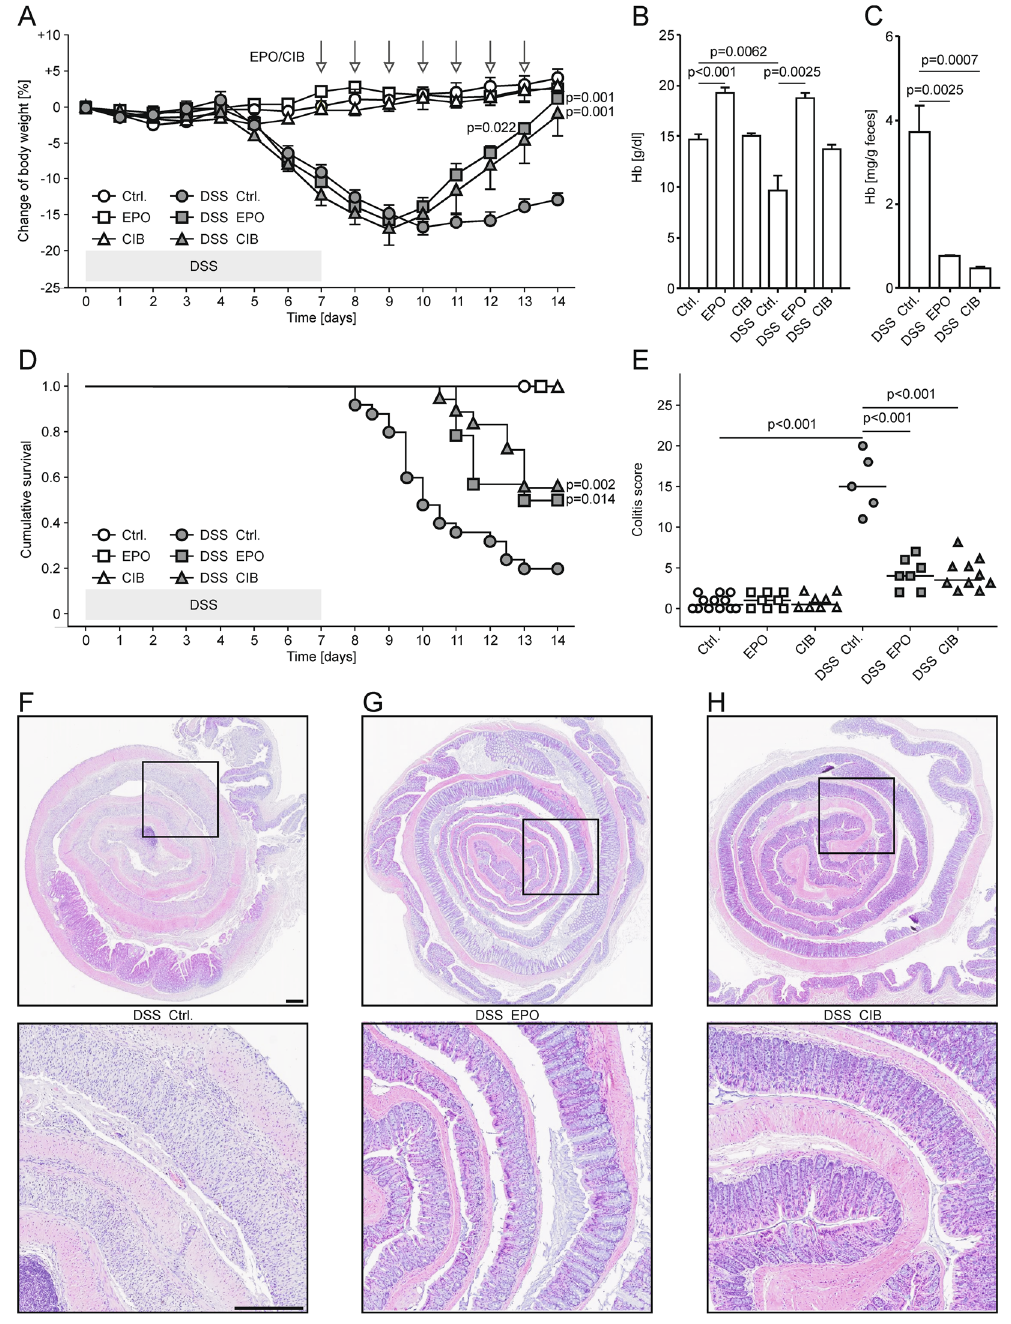
Figure 1. Cibinetide and EPO treatment improve disease activity in DSS-induced colitis. ( A ) C57BL/6N mice received drinking water or 3% DSS from days 1 to 7. Through days 8 to 14, all animals received drinking water. Starting on day 8, mice were daily injected with PBS (Ctrl.; given as solvent), 1.5 pmol/g body weight rhu erythropoietin (EPO) or 1.5 pmol/g body weight cibinetide (CIB) as indicated by arrows. The change in body weight is expressed as percentage of body weight from day 0, and data are shown as means ± S.E.M. for 5–12 mice per group. Results were compared by ANOVA using Bonferroni correction. Statistical significant differences between DSS-mice treated with EPO or CIB in comparison to PBS treatment are indicated next to the corresponding symbol. ( B ) Hemoglobin (Hb) levels of the animals presented in (a) were measured on day 14 by an automated veterinary cell counter. Data were compared by Kruskal-Wallis testing. Data are shown as means ± S.E.M. n = 5–12 mice per group. ( C ) Fecal Hb levels were measured on day 14 and normalized for dry weight. Data were compared by Kruskal-Wallis testing. Data are shown as means ± S.E.M. n = 5–9 mice per group. ( D ) Survival of DSS-exposed mice treated with PBS, CIB, or EPO was followed for 14 days. Data were compared by log-rank test and are depicted as Kaplan-Meier plot. n = 3 per group for mice on drinking water, n = 14–24 per group for mice on DSS. ( E ) Histopathological colitis scores of mice receiving drinking water or 3% DSS and subsequently treated with PBS, CIB, or EPO ( n = 5–12 per group). Each point